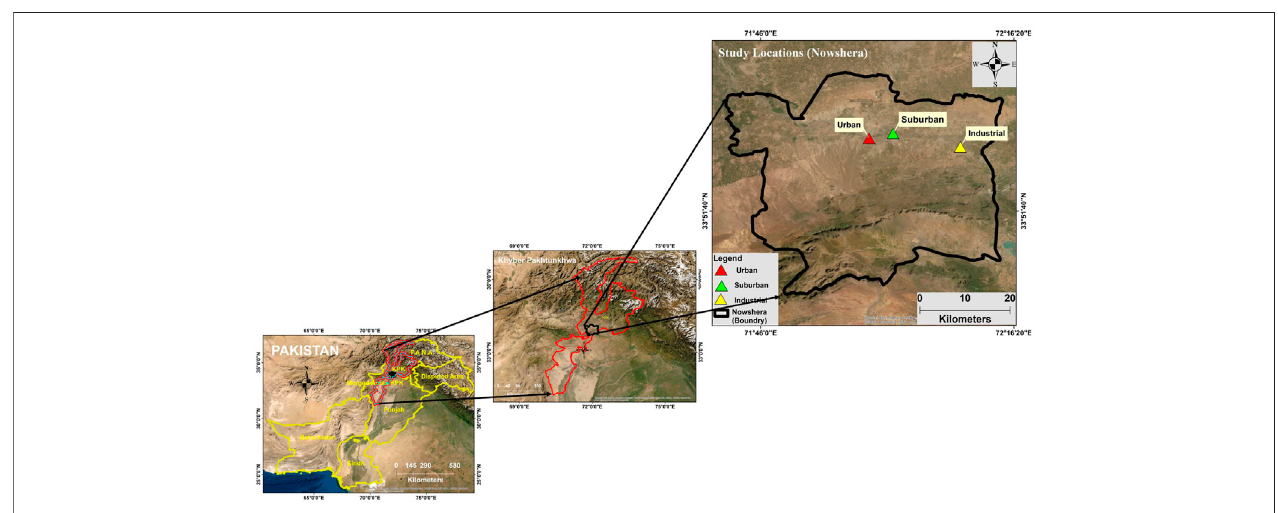
FIGURE 1 | Map of study locations of